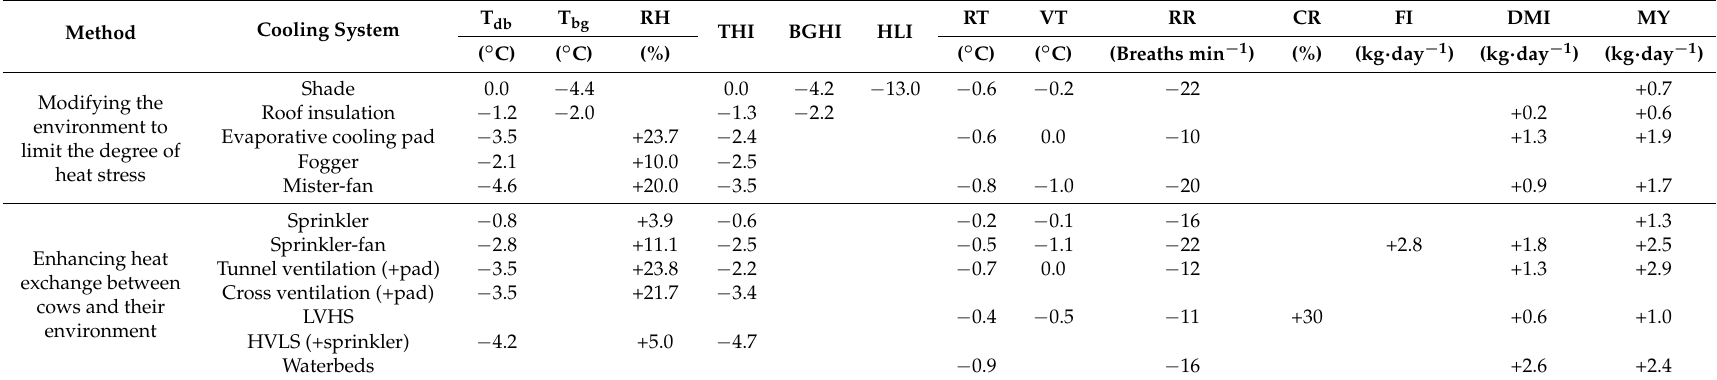
Table 12. Average improvements of potential cooling systems for humid continental farms on meteorological and thermal stress attributes and physiological response of dairy